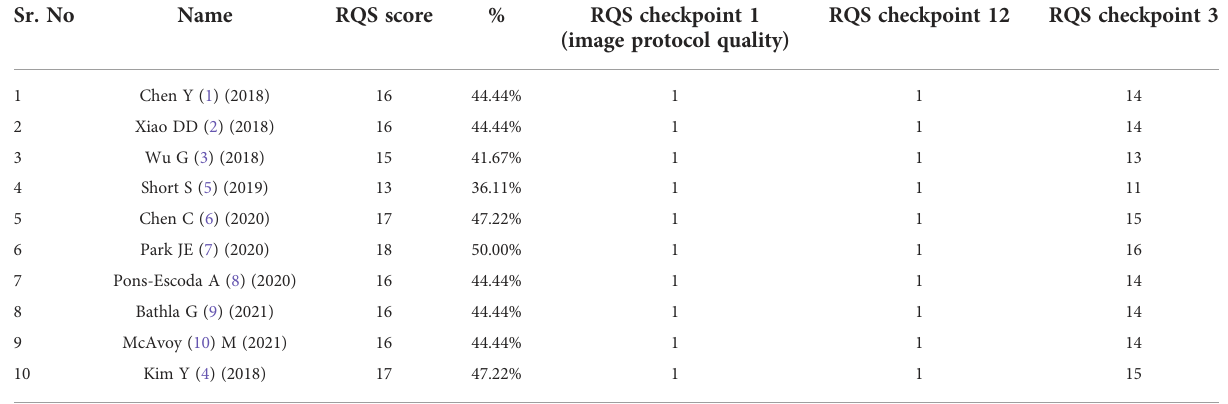
TABLE 4 Summary of Radiomics Quality Score (RQS) of individual studies. Sr. No